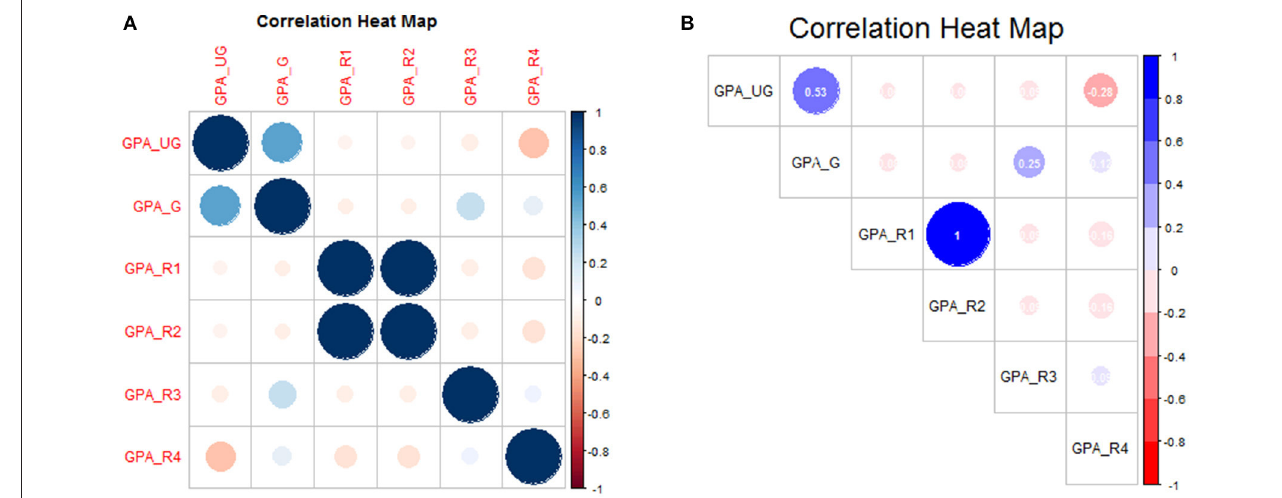
FIGURE 4 | Default plot (A) and modified plot (B) of correlation matrices of multi-variate GPA data.